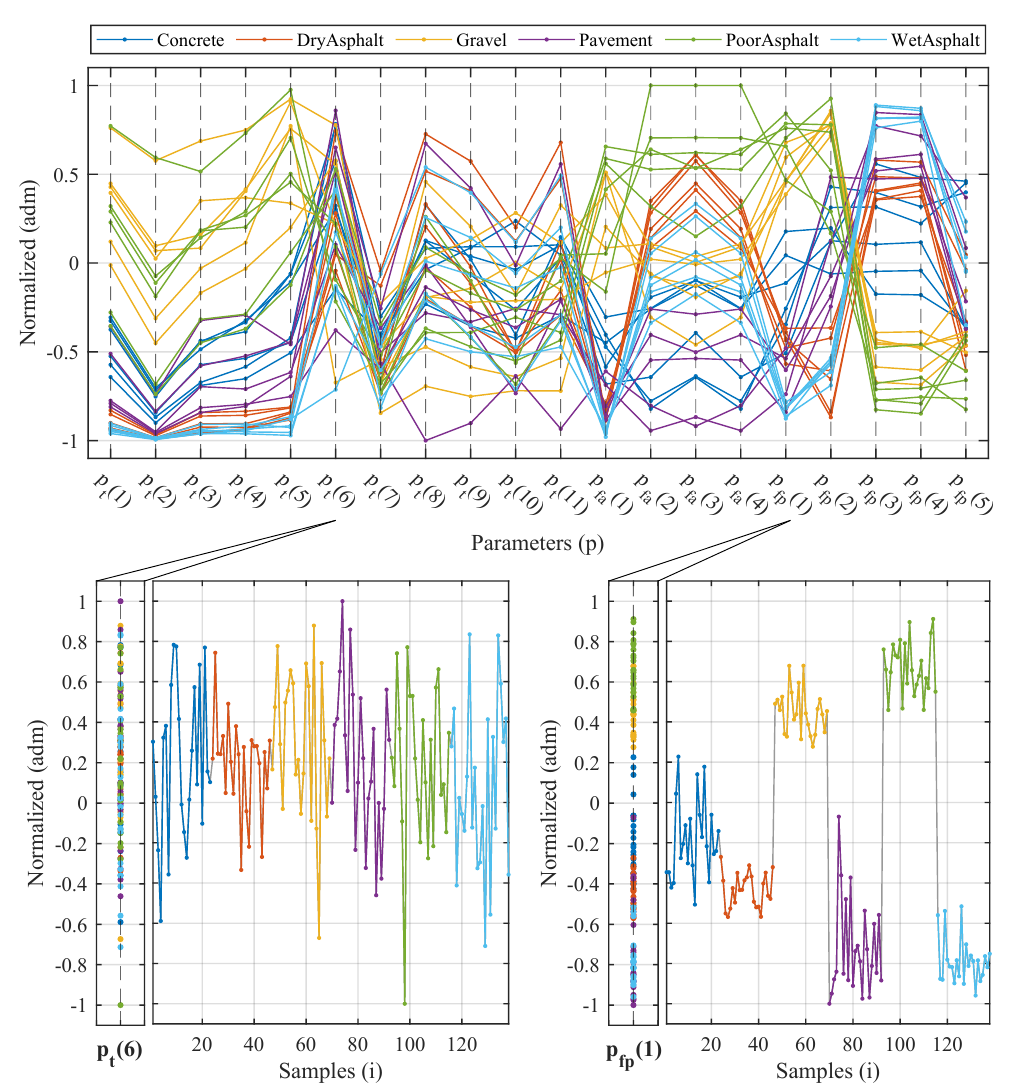
Figure 11. Parameter inspection sample with ( right ) good and ( left ) bad rating